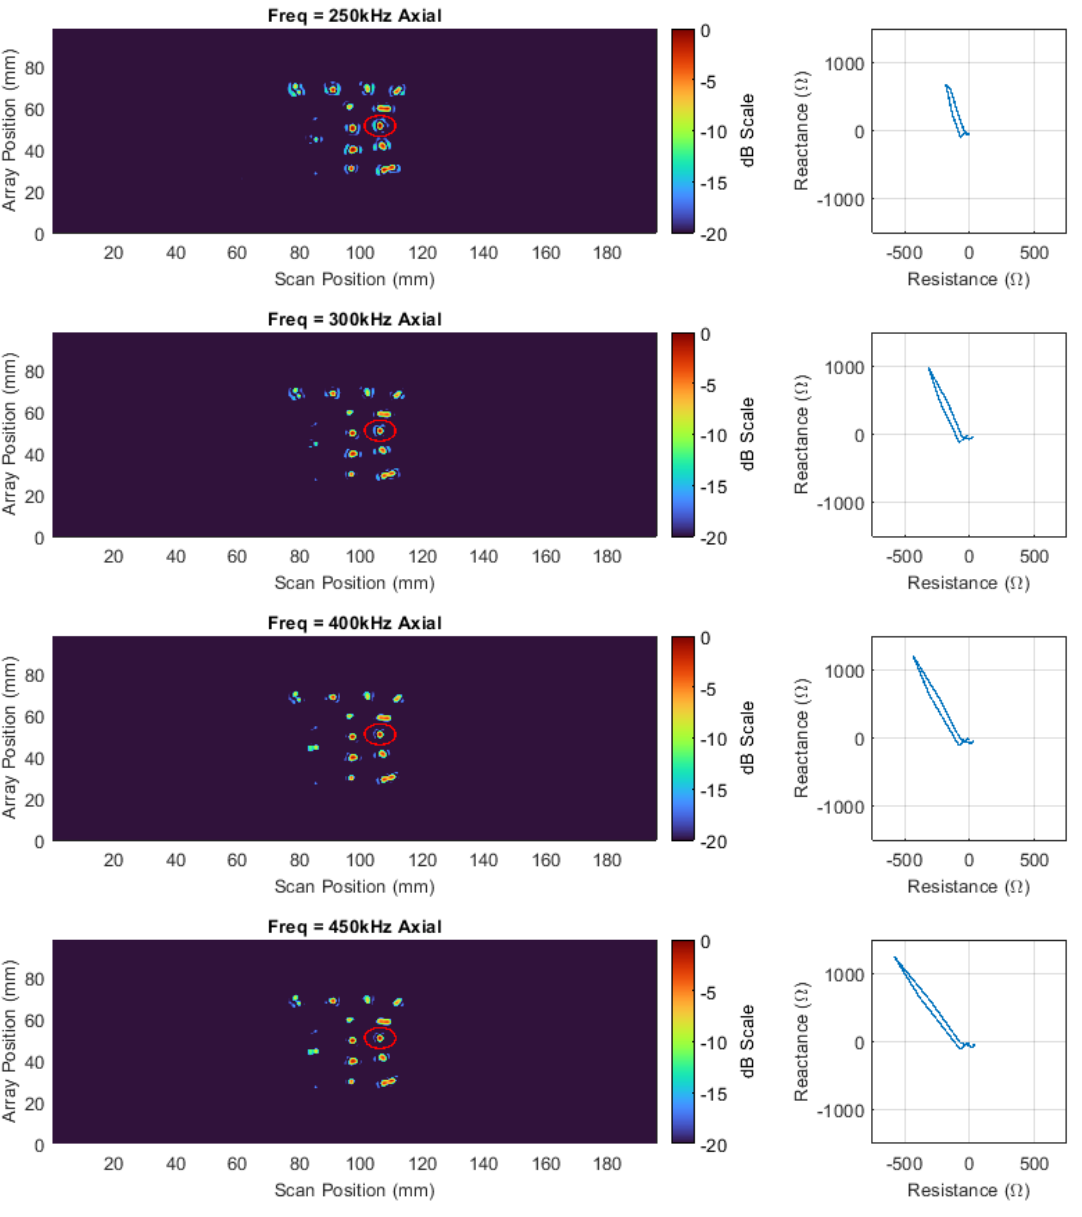
Figure 10. Phase-rotated axial vertical impedance component C − scan images at 250,300,400 and 450 kHz on a dB scale alongside impedance plane plots of the response from the highlighted defect.